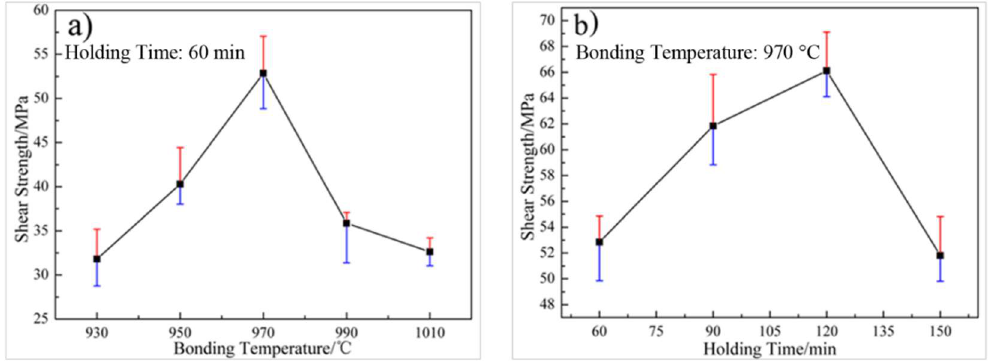
Figure 6. Effect of bonding parameters on the shear strength of joints. ( a ) Bonding temperature; ( b ) holding time.